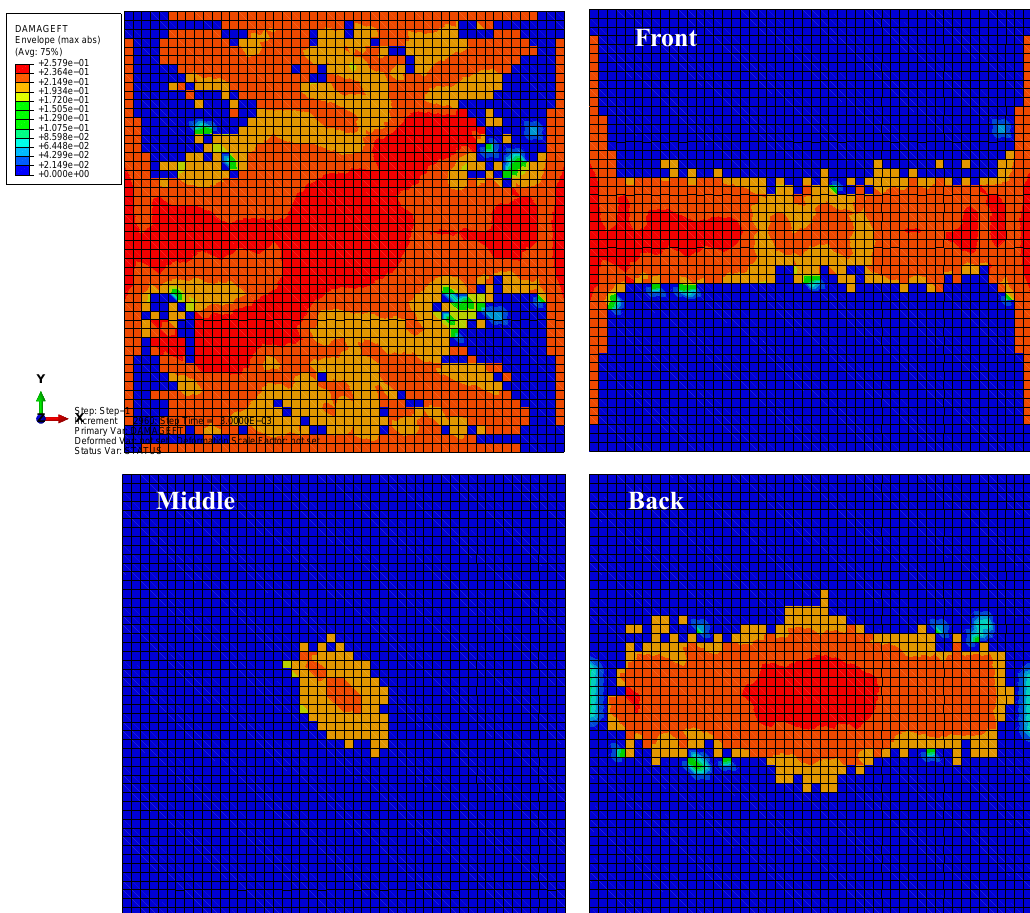
Figure 9. The fiber tension damages at different plies of the plate with material 2.